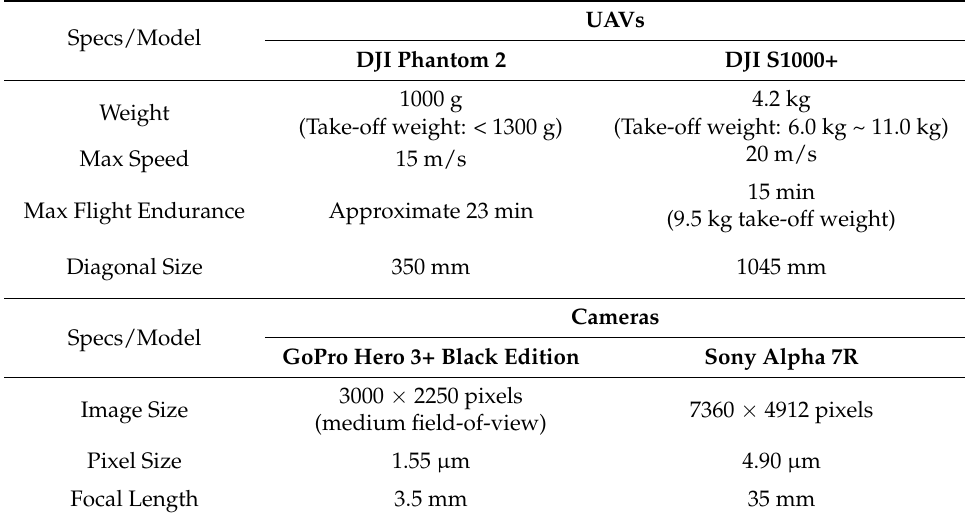
Table 1. Specification of the utilized UAV and